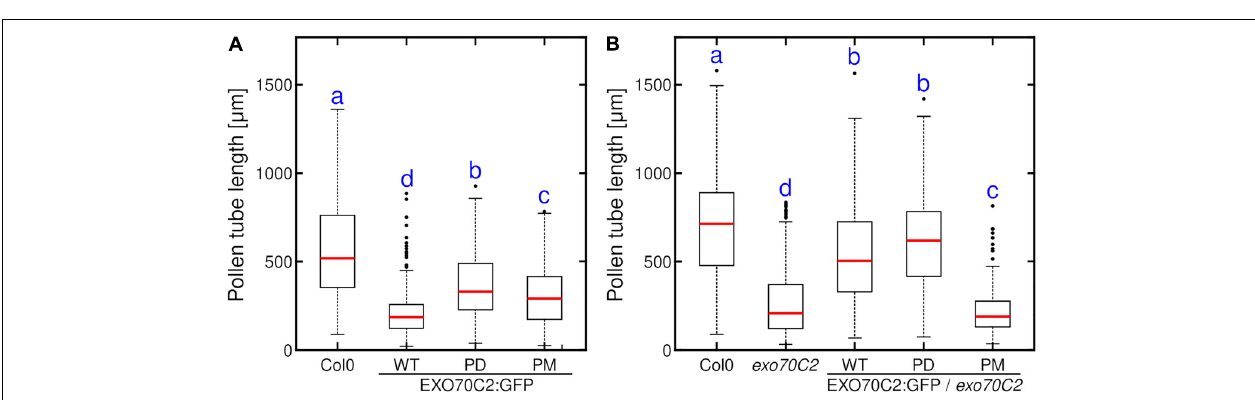
FIGURE 5 | Expression of phospho-dead EXO70C2 differently affects the growth of Arabidopsis wild type and exo70C2 mutant pollen tubes. Quantitative analysis of pollen tube length of Arabidopsis wild type (WT) (A) and exo70C2 mutant (B) expressing EXO70C2p:AtEXO70C2:GFP wild type, phospho-dead (PD), and phospho-mimetic (PM) variants. Pollen tubes from Col-0 ecotype and exo70C2 mutant that did not express any GFP-fused AtEXO70C2 variant were used for comparison as positive and negative controls, respectively. Measurements were performed on 148 or more pollen tubes for each variant imaged during three independent experiments. Different letters indicate significant differences between samples at P <